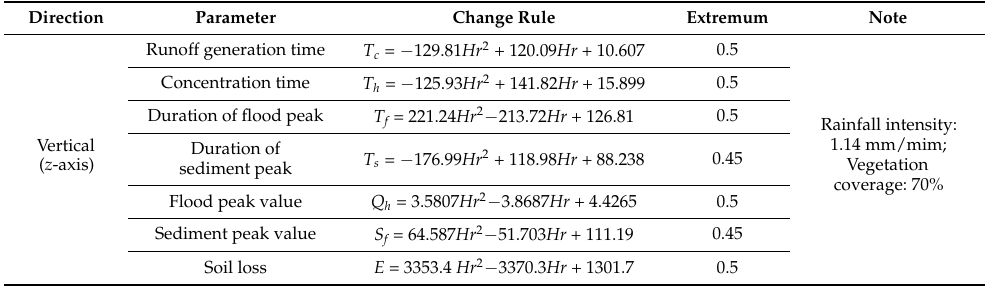
Figure 5. Variation law of erosion transport in watershed under different terrace longitudinal layout ( y -axis). (( a ) L - T c /T h ; ( b ) L - T f /T s ; ( c ) L - Q h /S f ; ( d ) L - E ). Table 7. Variation law of erosion transport in watershed under different terrace vertical layout ( z - axis).